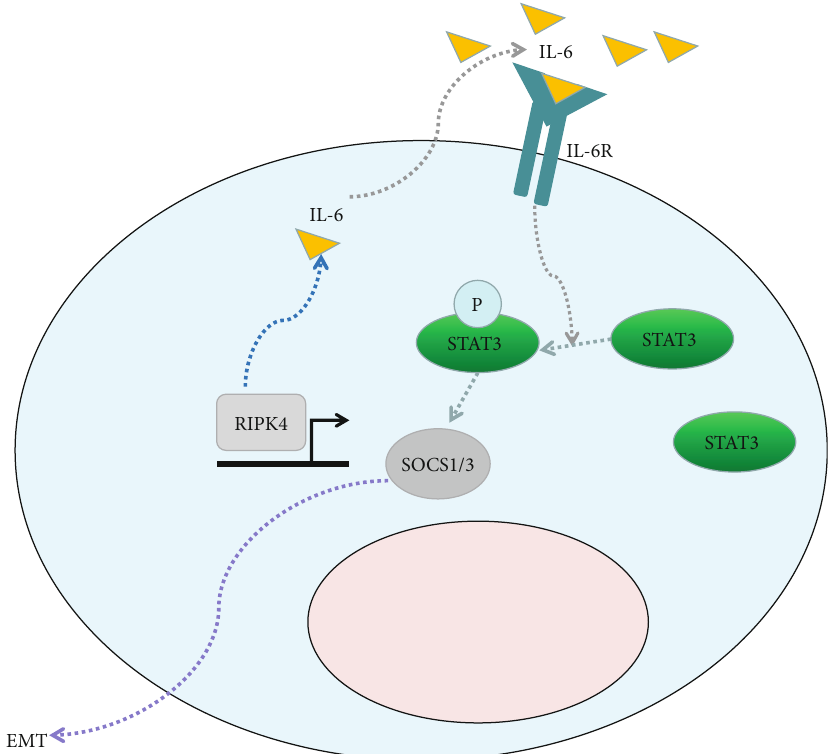
Figure 6: Functional model of the IL-6 involved in restraining EMT in OC progression after downregulation of RIPK4 expression. RIPK4- silenced OC cells hypoactivated IL-6 signalling. Less STAT3 was phosphorylated, and the expression of SOCS1/3 was reduced. Consequently, the RIPK4-based IL-6 network is a determinant of EMT in